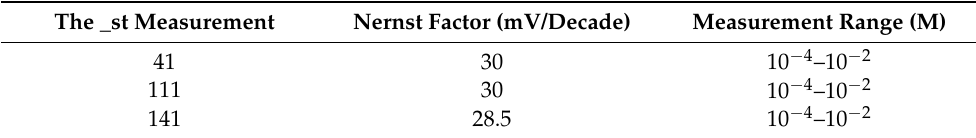
Table 7. Data of Nernst factor and measurement range in the determination of sensor